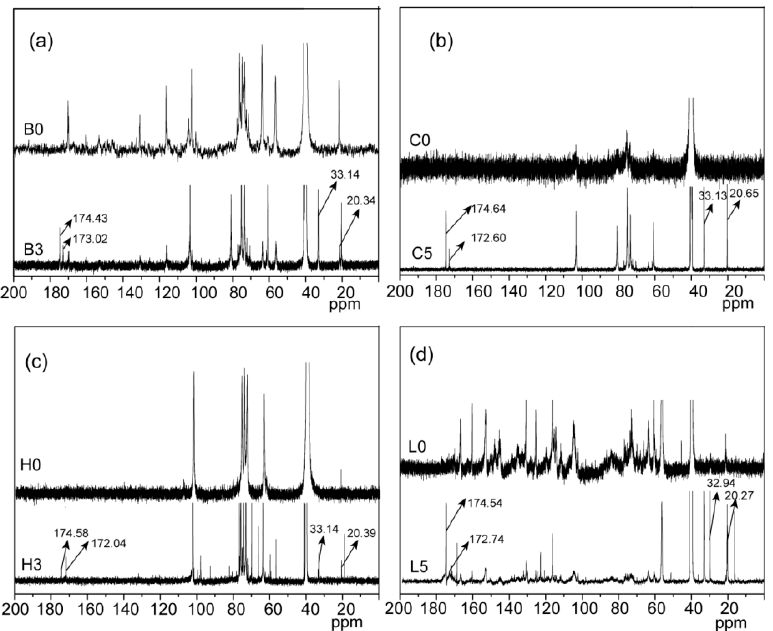
Figure 3. 13 C NMR spectra of bagasse ( a ); cellulose ( b ); hemicelluloses ( c ) and lignin ( d ) samples.